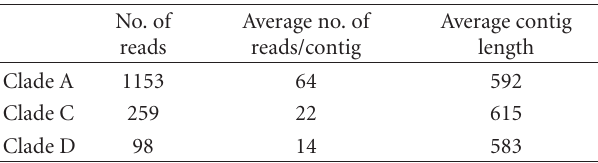
Table 1: Sequence statistics for the three clades of c92-like proteins present in